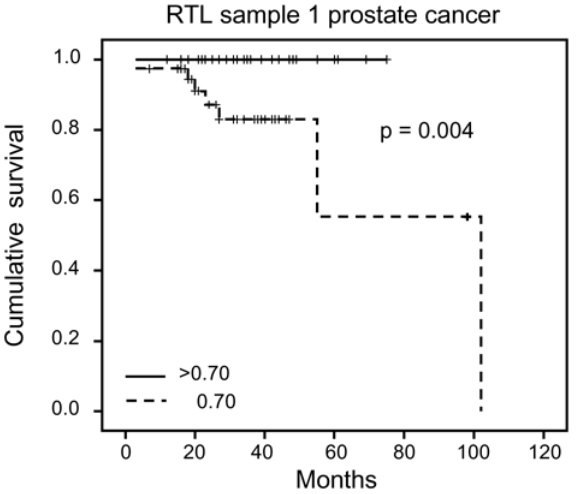
Table 1. Distribution of different tumor